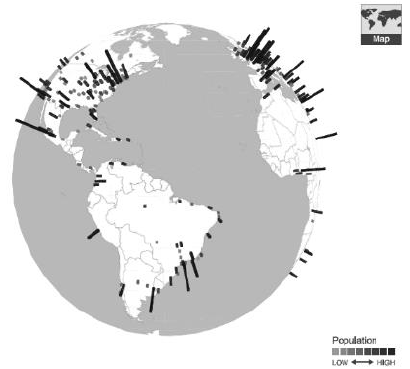
Figure 12. Mc Kinsey report interactive map from American continent.